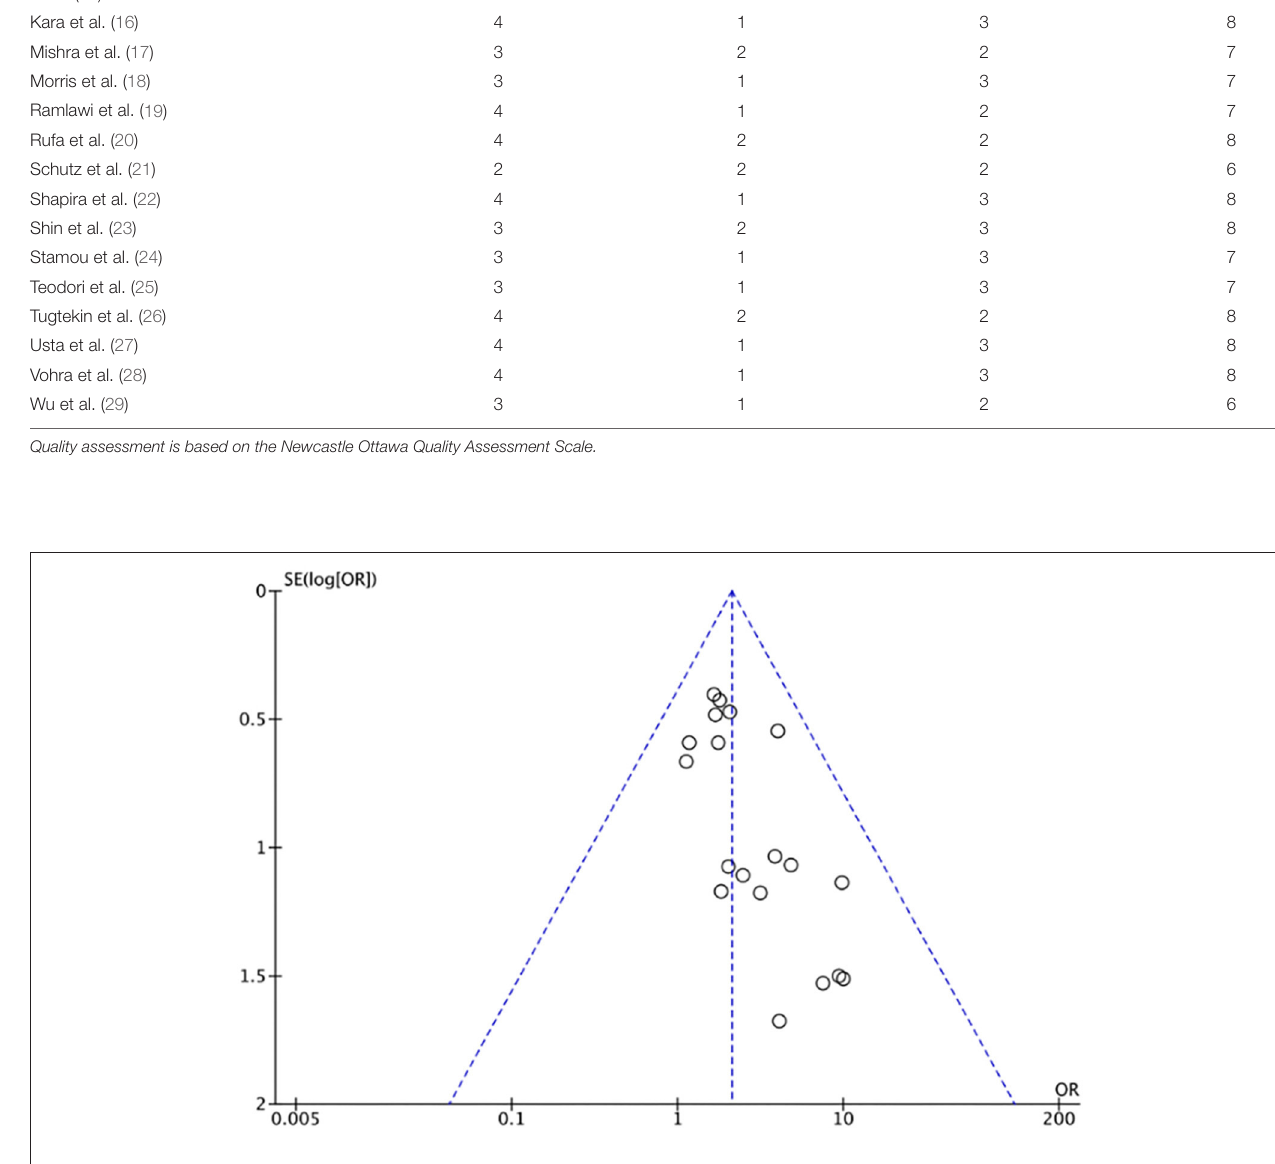
FIGURE 2 | Funnel plot for early